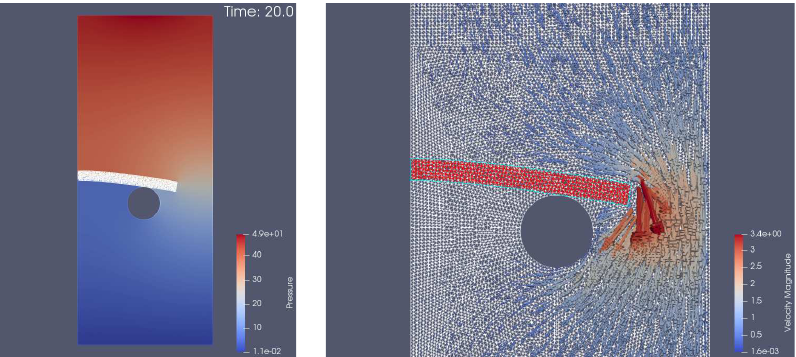
Figure 3. Computed solution at time instant t = 20 s: pressure ( left ) and zoom of velocity ( right